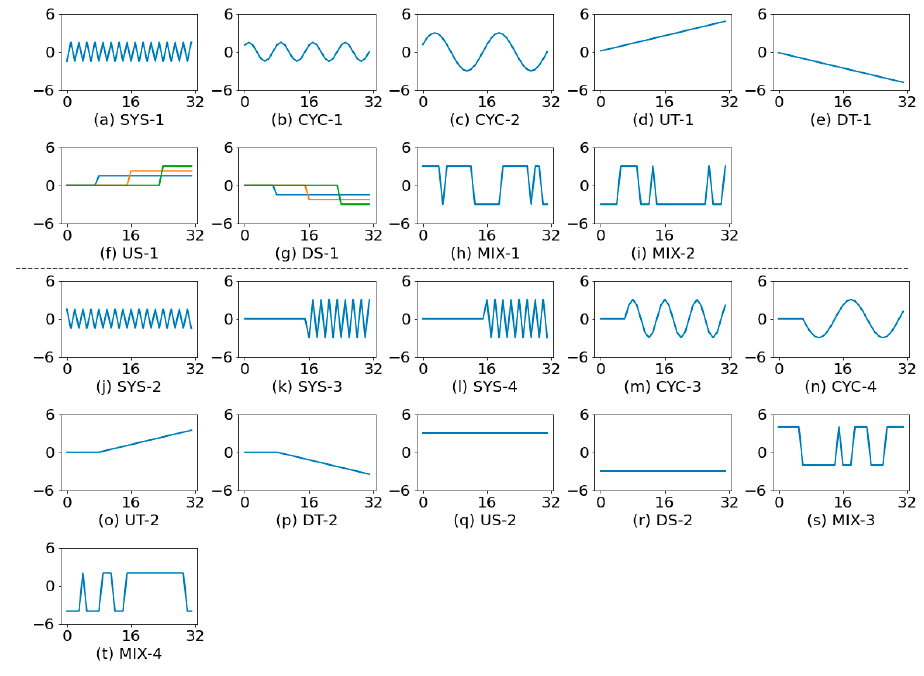
Figure 5. Variants of non-random patterns.